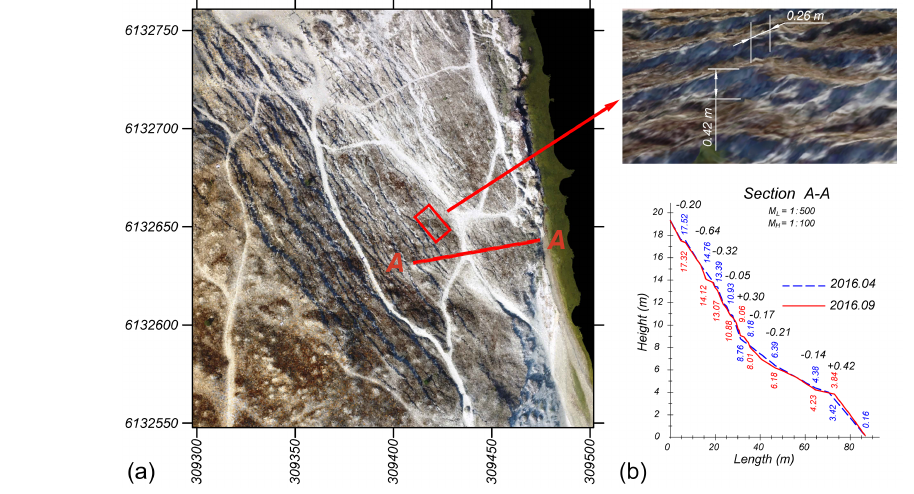
Figure 6. Investigation areas (left) and changes in micro-terrace parameters (right).